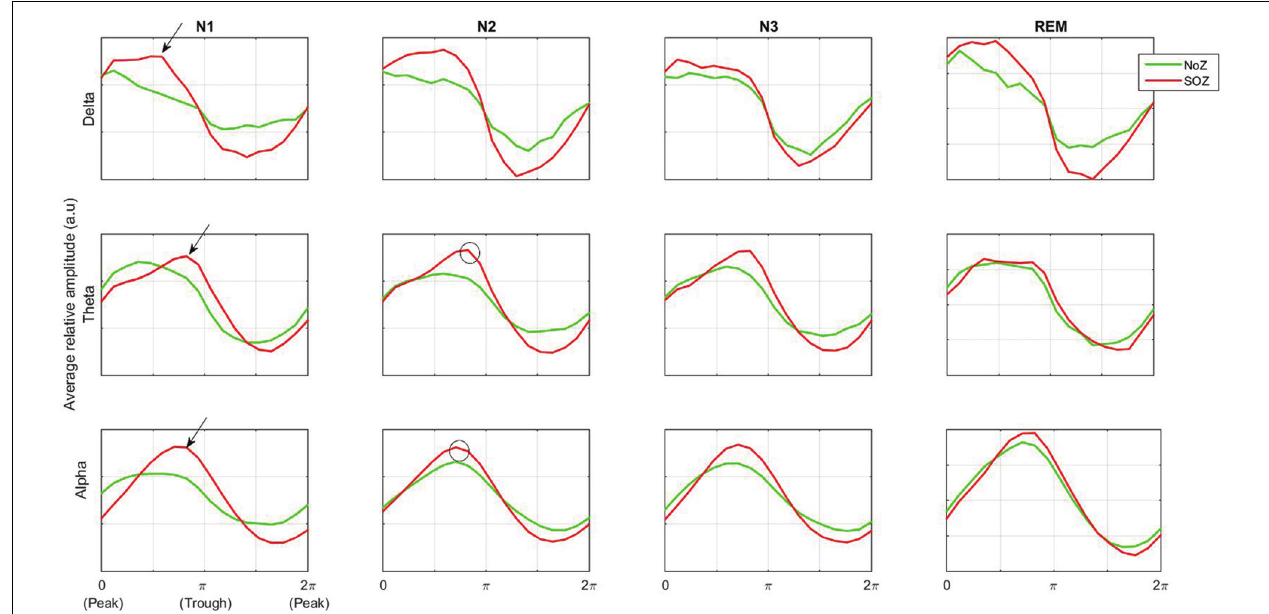
FIGURE 6 | Average ripple band amplitude as a function of low-frequency phase in normal and SOZ channels. Phases 0 and π correspond to the low-frequency band peak and trough respectively. The difference in preferred coupling phase in theta and alpha bands compared to delta band is shown by black arrows. More high frequency activity is seen at the trough of theta and alpha rhythms (black circles). NoZ, normal zone; SOZ, seizure onset